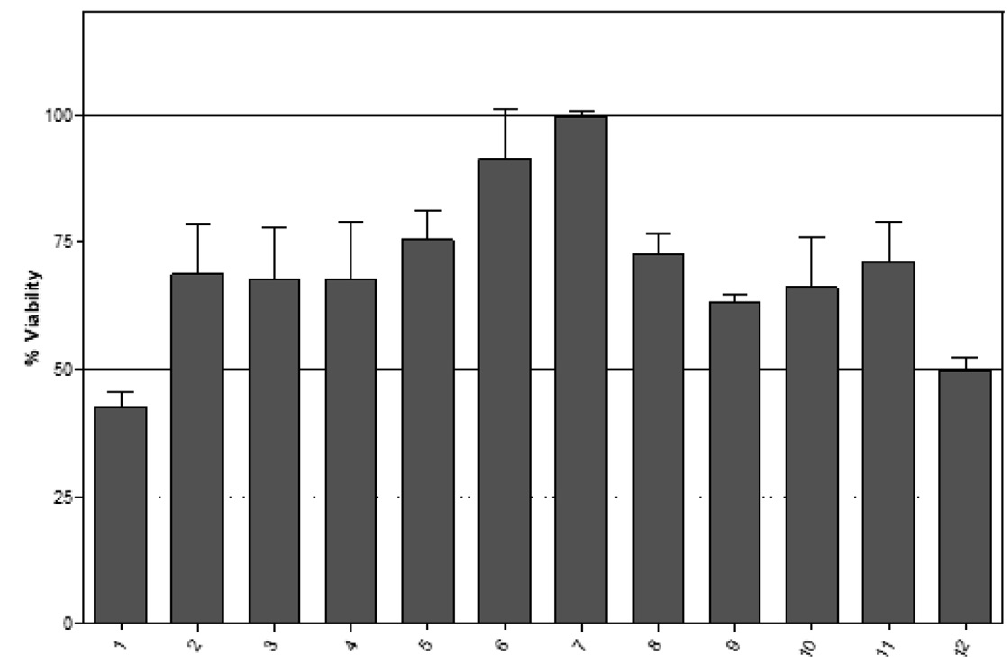
Figure 5. % HeLa cell viability ± SD obtained for compounds 1 – 12 .